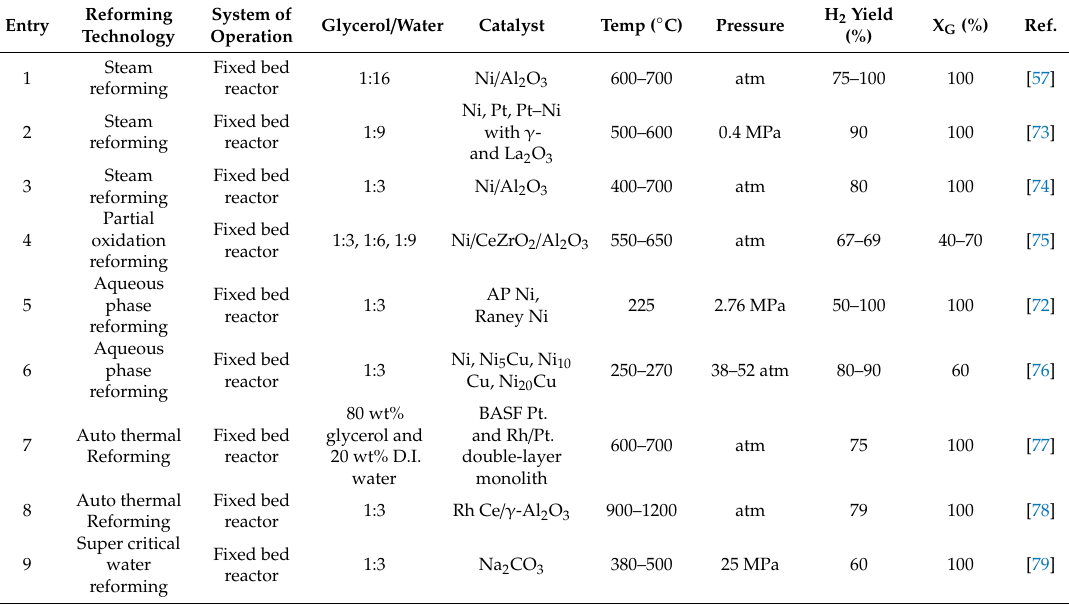
Scheme 6. Conversion of glycerol to hydrogen and syngas. Table 2. Review of literature on the conversion of glycerol to hydrogen and Table 2. Review of literature on the conversion of glycerol to hydrogen and syngas.